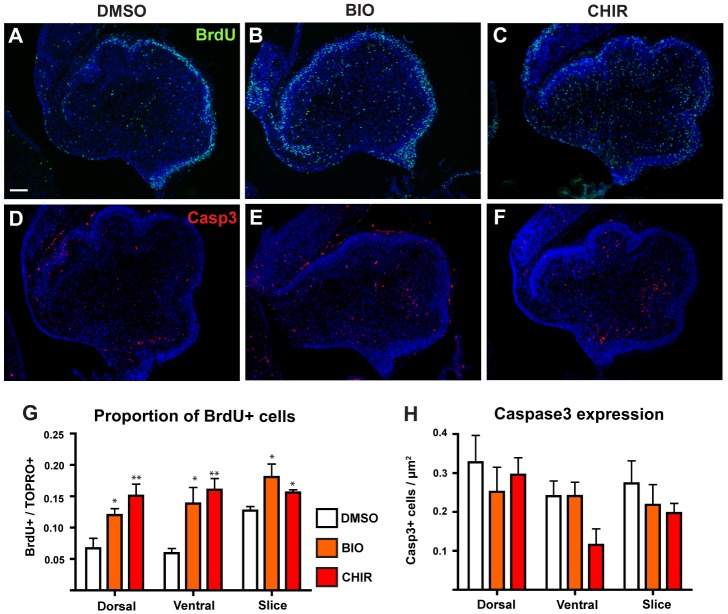
Wnt/β-catenin pathway activation ex vivo is mitogenic but has no affect on apoptosis.E18.5 cerebellum slices were cultured in the presence of DMSO (A,D), 20 µM BIO (B,E) or 50 µM CHIR (C,F) and analysed by immunohistochemistry for the retention of a BrdU label administered two hours prior to fixation (A–C) or apoptotic marker Caspase3 (D–F). (G) Graph showing proportion of BrdU+ cells in specific areas of cultured slices. (H) Graph showing density of Caspase3 labelled cells per unit area in specific regions of cultured slices. In all cases statistical comparisons were made by comparing each treatment group with the appropriate DMSO control using a Student's T-test. For each test, n = 3, error bars = SEM, * = p<0.05, ** = p<0.01, *** = p<0.001. All sections counterstained with TOPRO3. Scale bar = 100 µm.